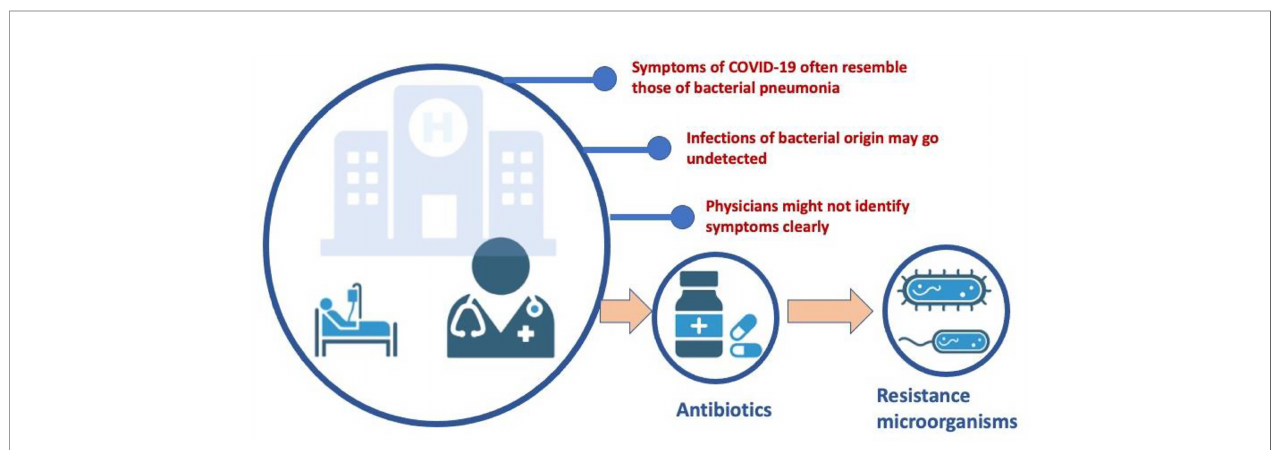
FIGURE 2 | Impact of COVID-19 on antibiotic prescribing. One of the potential consequences of the COVID-19 pandemic is the spread of antimicrobial resistance in the acute care setting as a result of increased antimicrobial use. Although antibiotics cannot destroy viruses, physicians are sometimes insuf fi ciently aware of the symptoms and natural course of respiratory infectious diseases and often prescribe antibiotics to those diagnosed patients in whom there is con fi rmation or high suspicion of bacterial coinfection or superinfection. Consequently, many hospitalized patients with COVID-19 are prescribed empirical antibiotics, often in the absence of microbiological con fi rmation of the